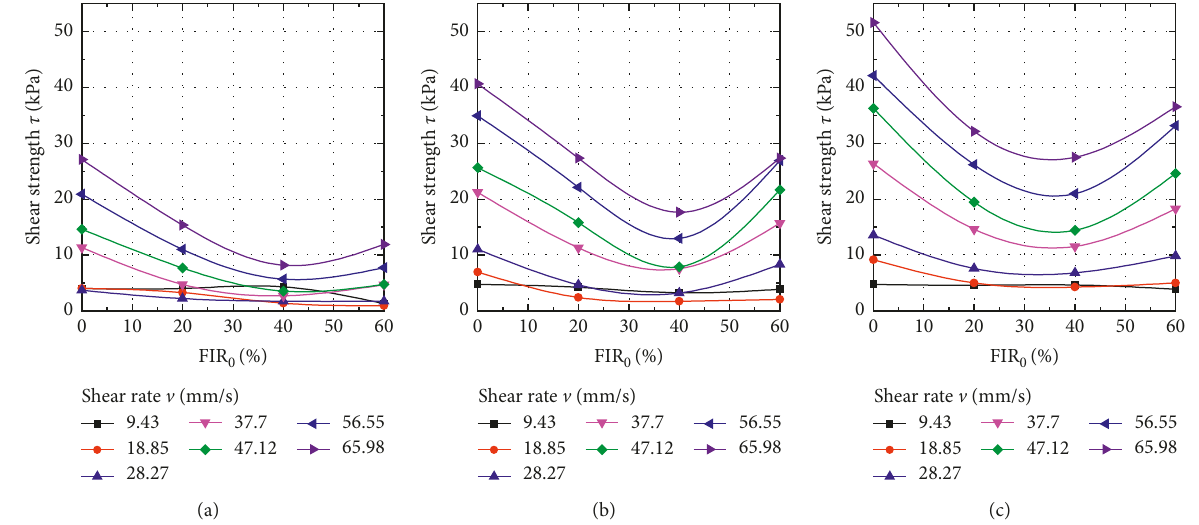
Figure 9: Effect of shear rate of the test device on shear strength of the foam-conditioned sand under different foam injection ratios FIR (a) FIR 0 20%; (b) FIR 0 40%; (c) FIR 0 (cid:31) (cid:31) (cid:31)